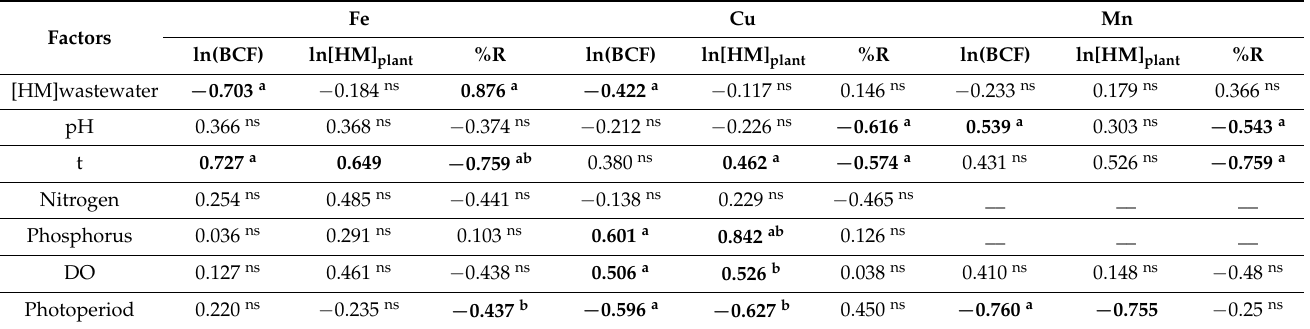
Table 3. Spearman’s correlation coefficients (r s ) for the factors of metal concentration in the wastew- ater ([HM]wastewater), pH, time, nitrogen, phosphorus, DO (dissolved oxygen) and photoperiod with the ln of the bioconcentration factor (BCF), the metal concentration in the plant ([HM]plant) and the percentage of metal removed (%R) from the